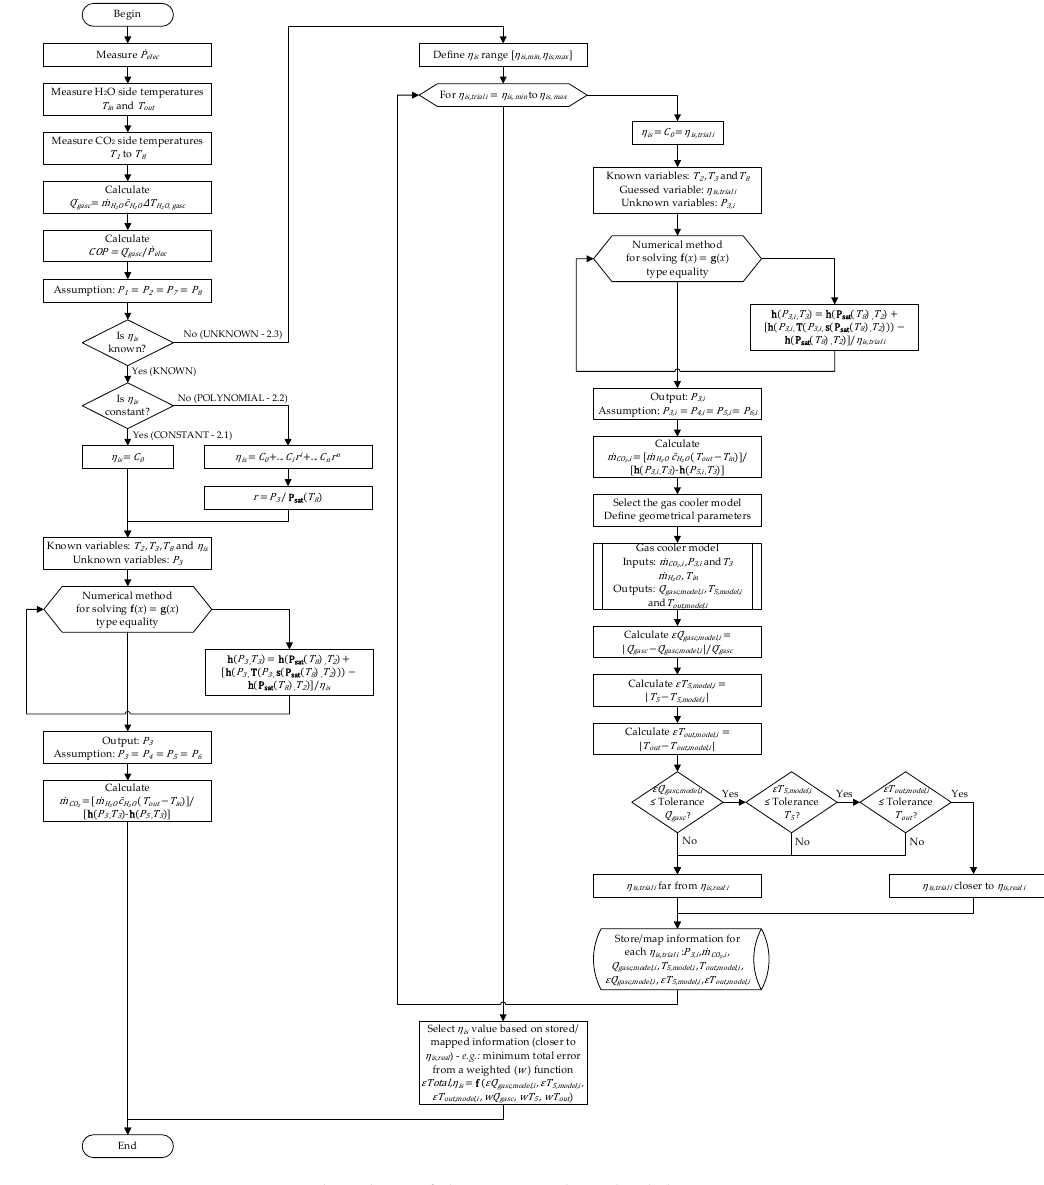
Figure 2. Flowchart of the proposed methodology. 154